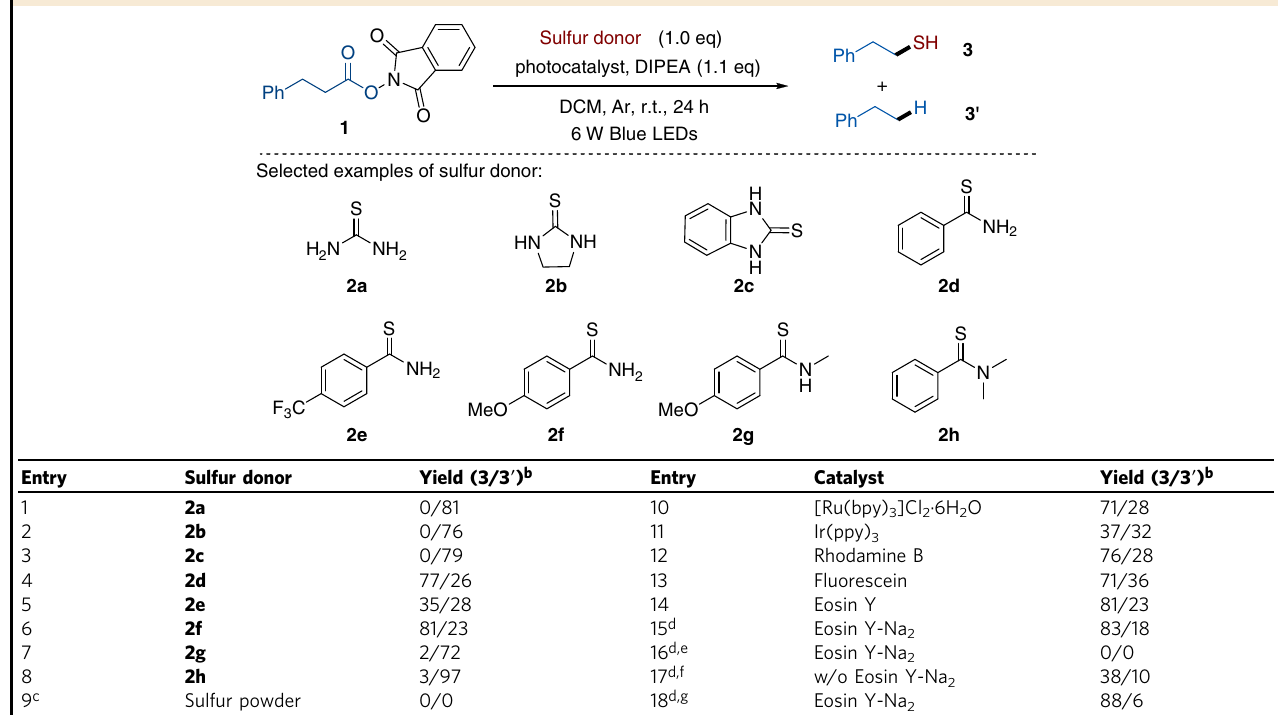
Table 1 Reaction optimizations for decarboxylative thiolation to free thiols a